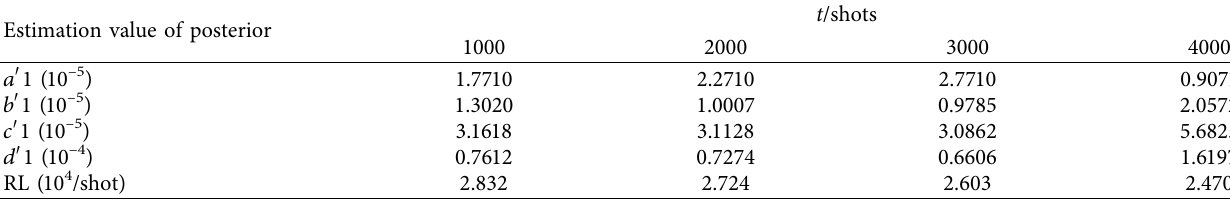
Table 3: Updated hyperparameters based on the Bayesian method (1st